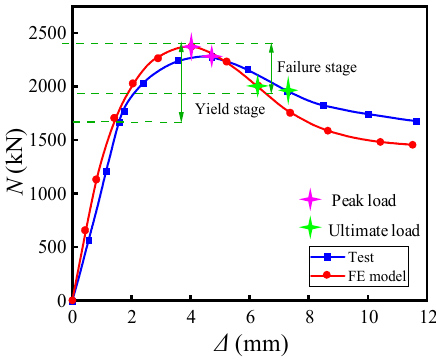
Figure 12. Comparison of load–displacement curves.